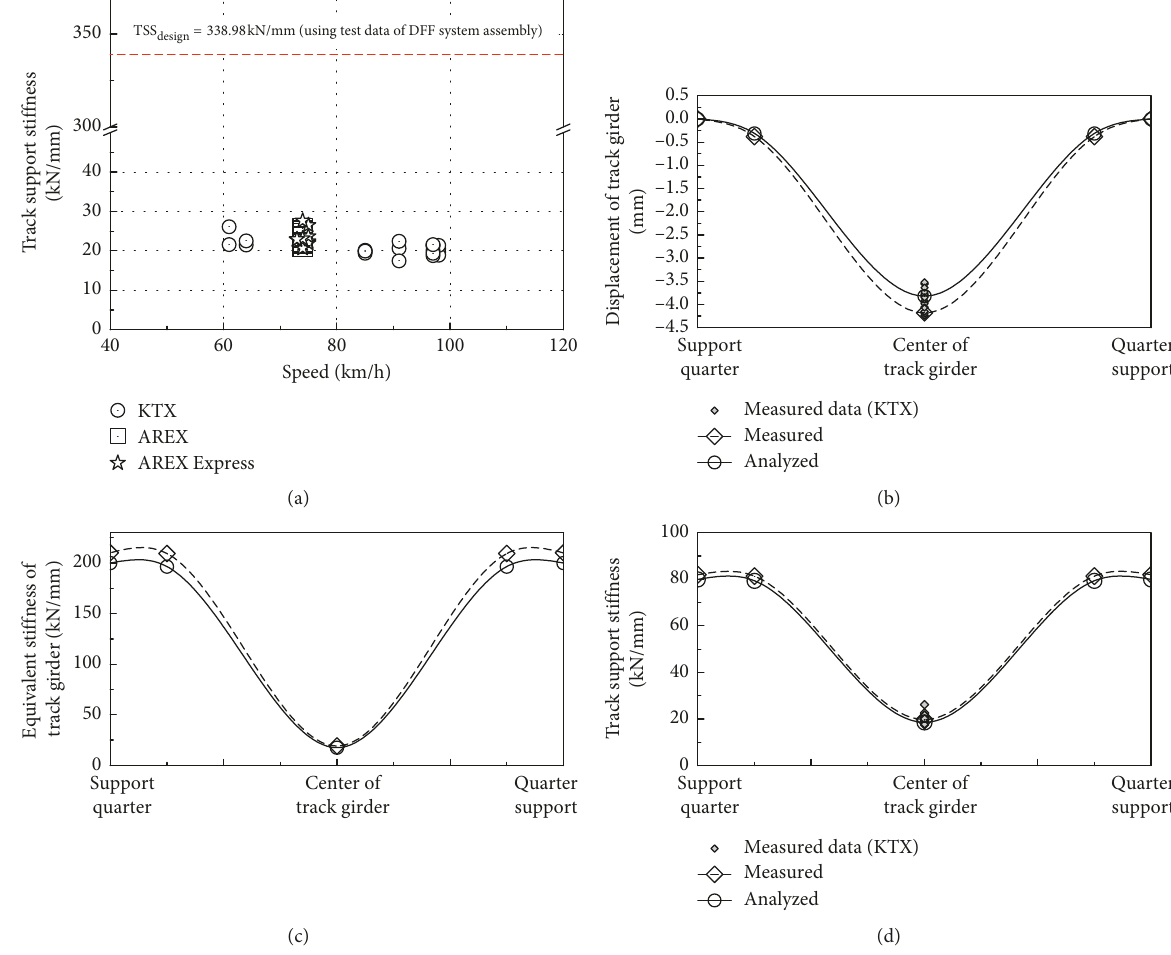
Figure 6: (a) Measurement results of track support stiffness for each train type. Comparison between analysis and experimental results: (b) displacement of the track girder; (c) equivalent stiffness of the track girder; (d) the track support stiffness.